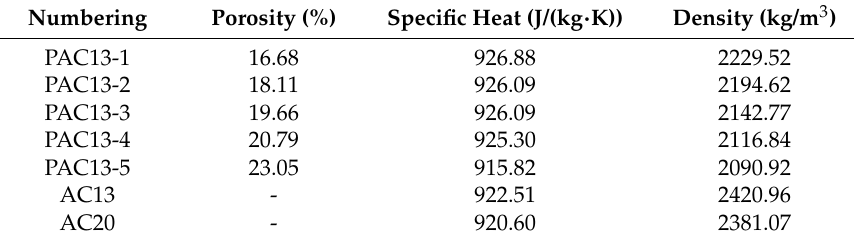
Table 8. Specific heat and density of 5 cm thick specimens.